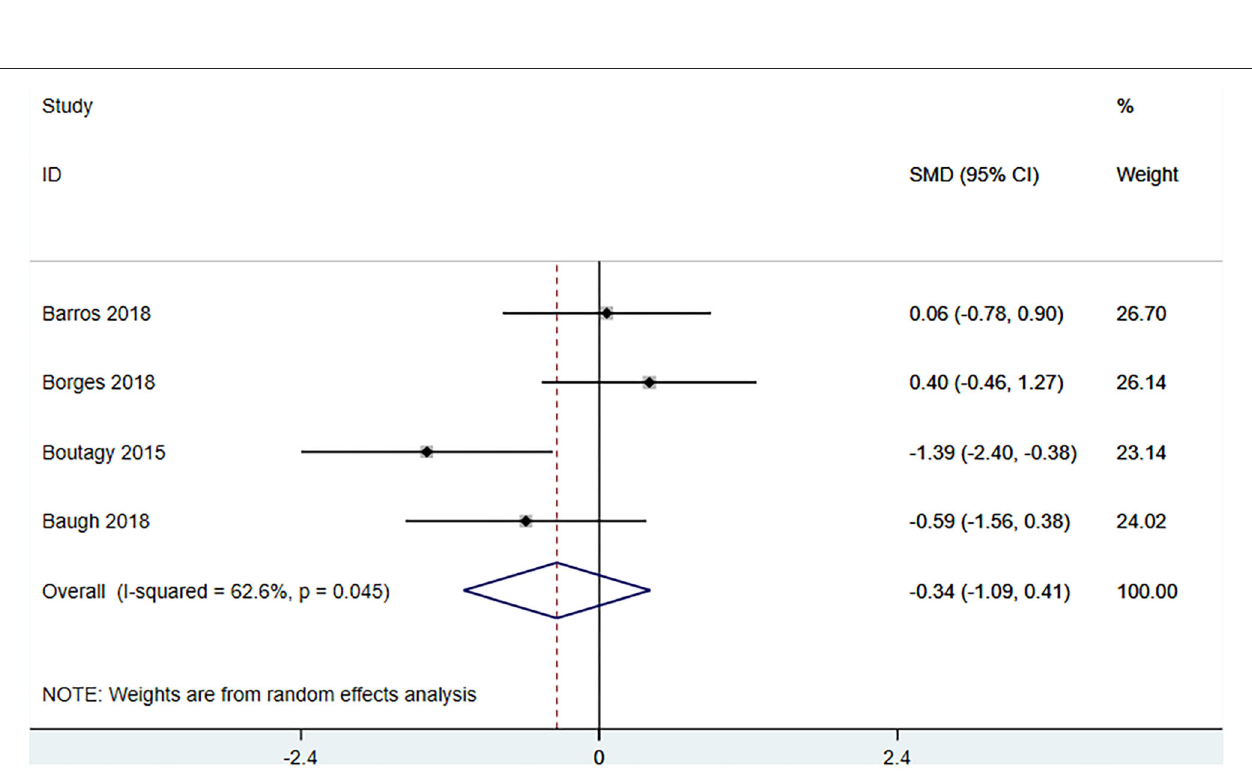
FIGURE 7 | Forest plot for the effect of microbiota-driven therapy on circulating choline level. The effect size of each trial or the overall was represented as black diamond and the weight of each trail in the overall study was represented as gray box around black diamond. The estimated 95% confidence interval of effect size was identified by extending lines. CI, confidence interval; RCT, randomized controlled trial; SMD, Standard Mean Difference.